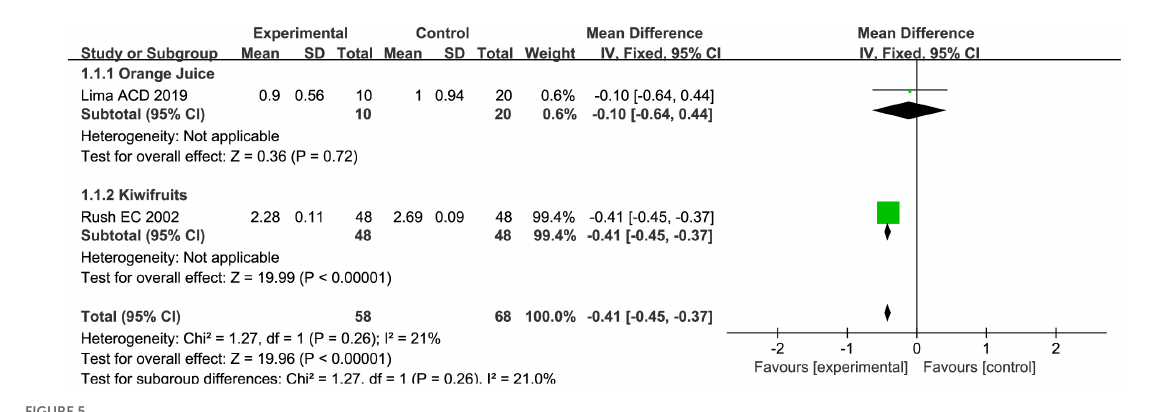
FIGURE5 Intervention effect of different types of fruits vs. placebo for stool consistency on patients in subgroup meta-analysis.